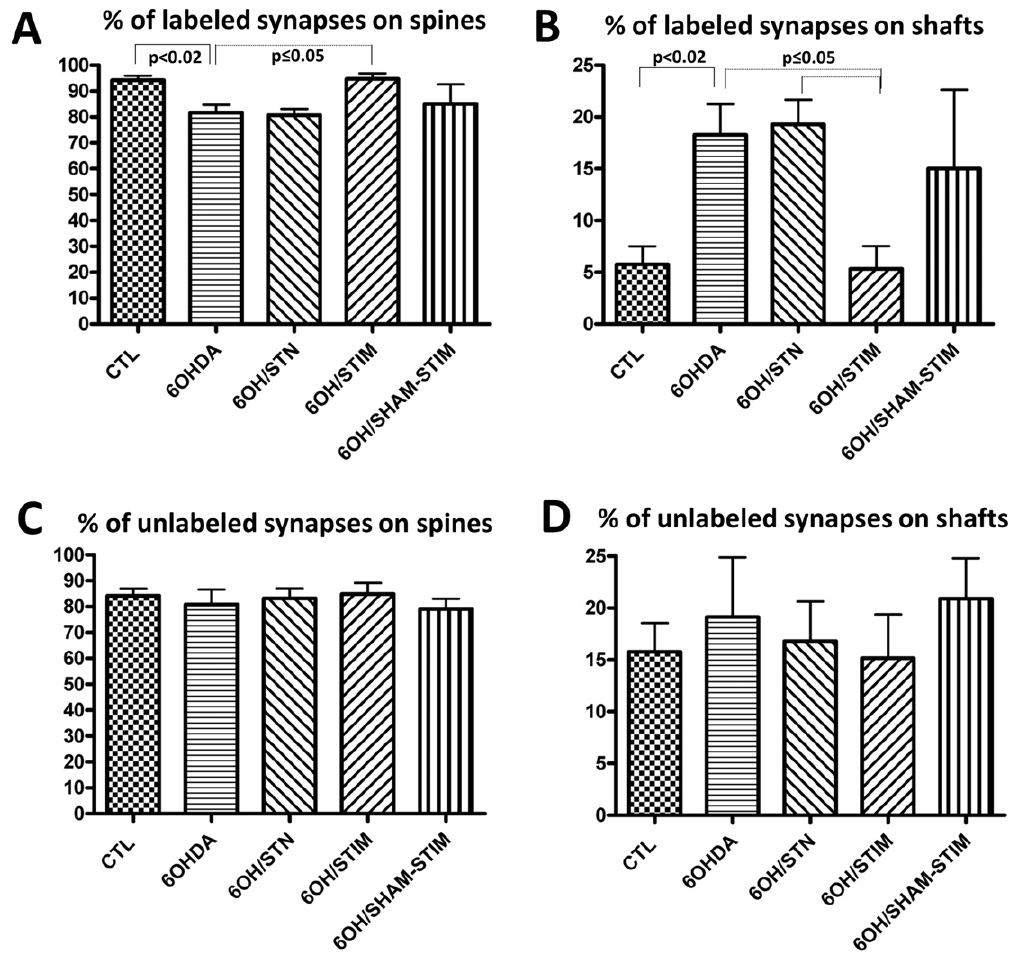
Figure 4. Comparison of localization of VGLUT1-labeled and -unlabeled terminals between groups. Percentages of VGLUT1-labeled terminals synapsing upon dendritic spines (A) and shafts (B) in the 5 experimental groups; control (n=8), 6OHDA-lesioned (n=6), 6OHDA + STN lesion (n=5), 6OHDA + STN stimulation (n=4), and 6OHDA + sham stimulation (electrode placement alone; n=3). In 6OHDA-lesioned animals, there was a shift from synapses on spines to upon shafts (p , 0.02), which was reversed by STN stimulation (p , 0.05). Percentages of non-VGLUT1-labeled terminals synapsing upon dendritic spines (C) and shafts (D). There were no significant differences between any of the experimental groups for unlabeled